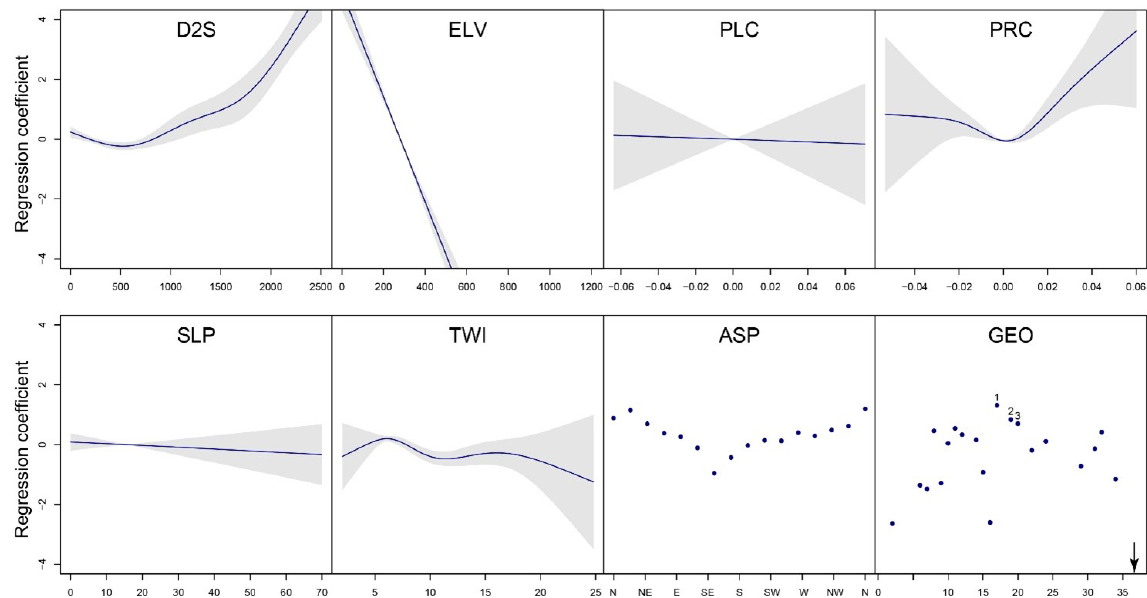
Figure 6. Covariate effects estimated for TEGs. Notably, the regression coefficients estimated for outcropping lithologies also host strong negative values. For pure visualisation purposes, we have focused on representing a coefficient range in which the positive classes would still appear to be visible. Also, to avoid cluttering the text, we have described in the text only the three strongest and positive contributors, labelled 1, 2, and 3 in the image.